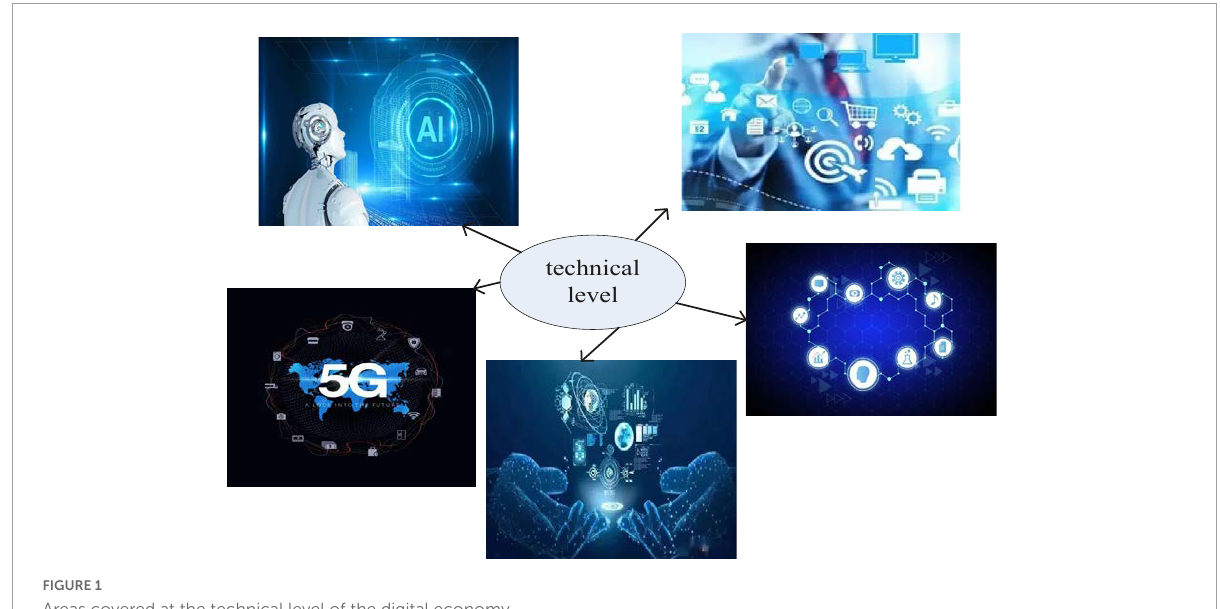
FIGURE1 Areas covered at the technical level of the digital economy.